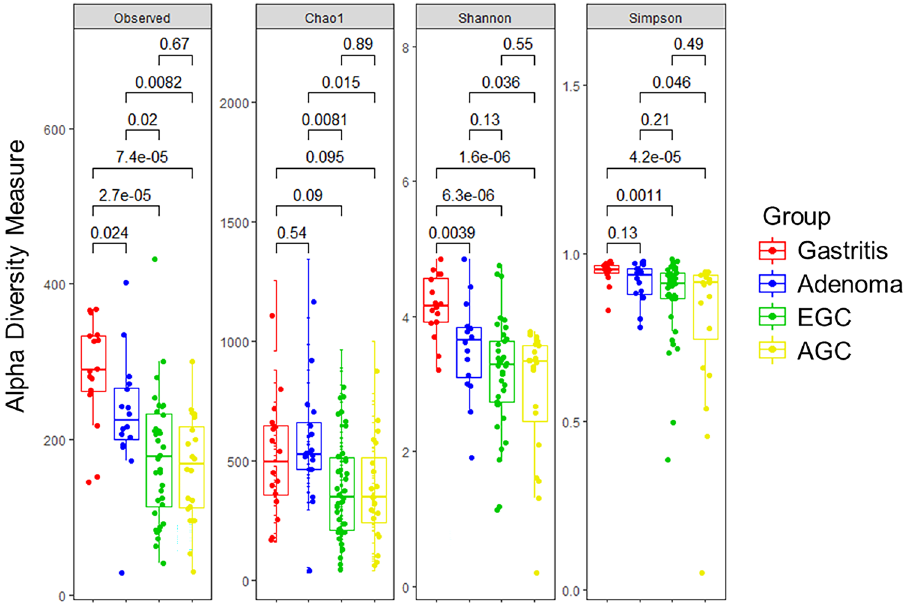
Figure 1. Comparison of alpha diversity of gastric microbiome in each stage of gastric carcinogenesis. Alpha diversity indices (Observed OTUs, Chao1, Shannon, and Simpson index) were calculated and compared between the four groups (GA, GAD, EGC, and